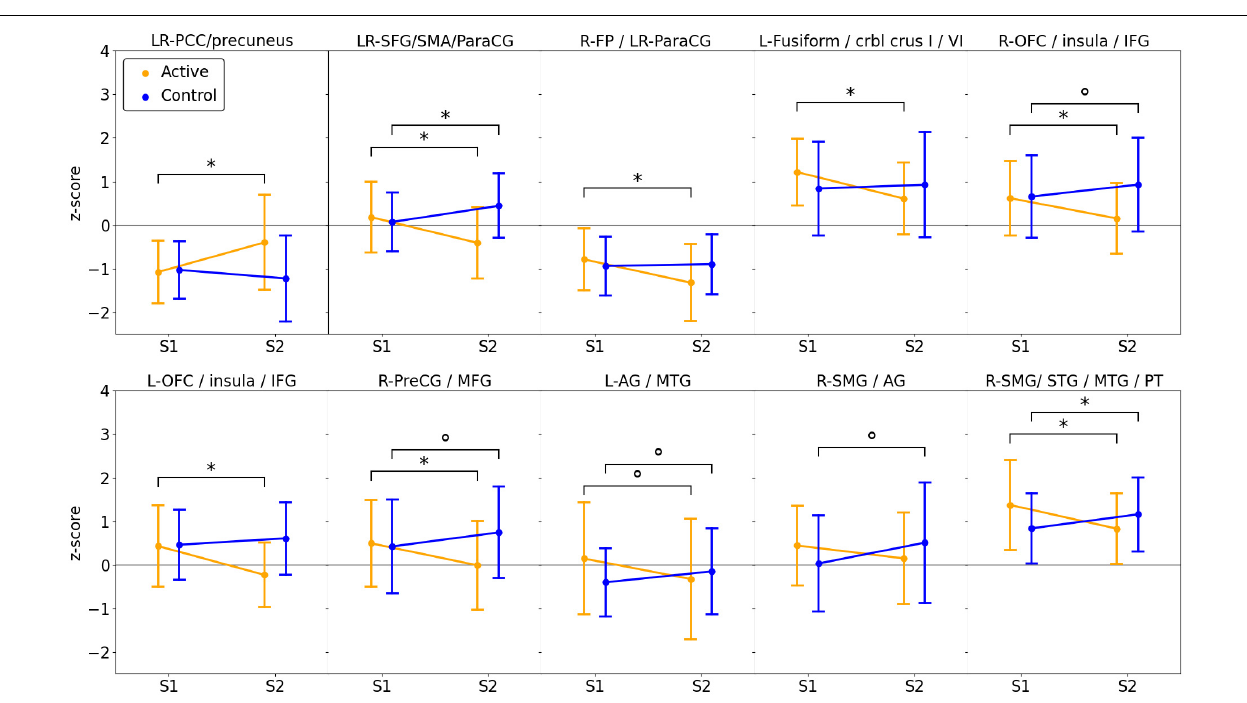
FIGURE 4 | Line Graphs Demonstrating Average Activation for Each Group and Session within Each Cluster Displayed in Figure 3 . Statistically significant differences between sessions (paired t-test) are shown by brackets and an asterisk (*), trends (0.05 < P < 0.1) are indicated by a circle ( ◦